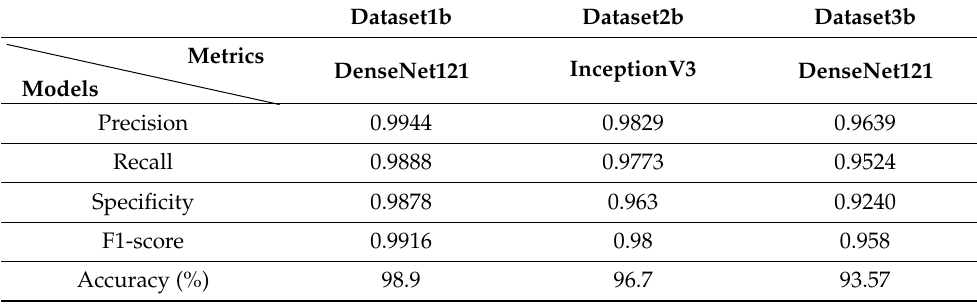
Table 2. Classification performance indicators of various fine-tuned models on